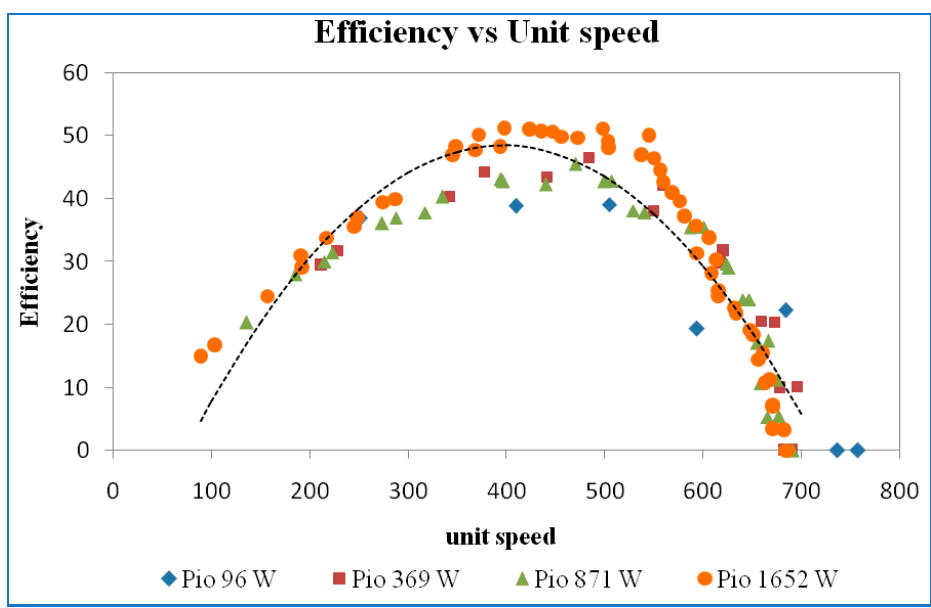
Figure 36. Efficiency vs. unit speed at a guide vane opening of 19 mm. Using results obtained for other GVOs, as mentioned in Table 1, variations of unit quantities at the best efficiency point were plotted concerning GVO. The results presented in Figure 37 show the values to be more or less constant for all guide vane openings. Table 1. Best efficiency points from characteristics of Francis